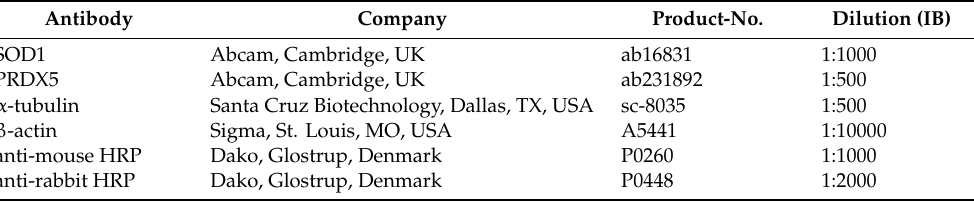
Table 1. Antibodies and dilutions used in this